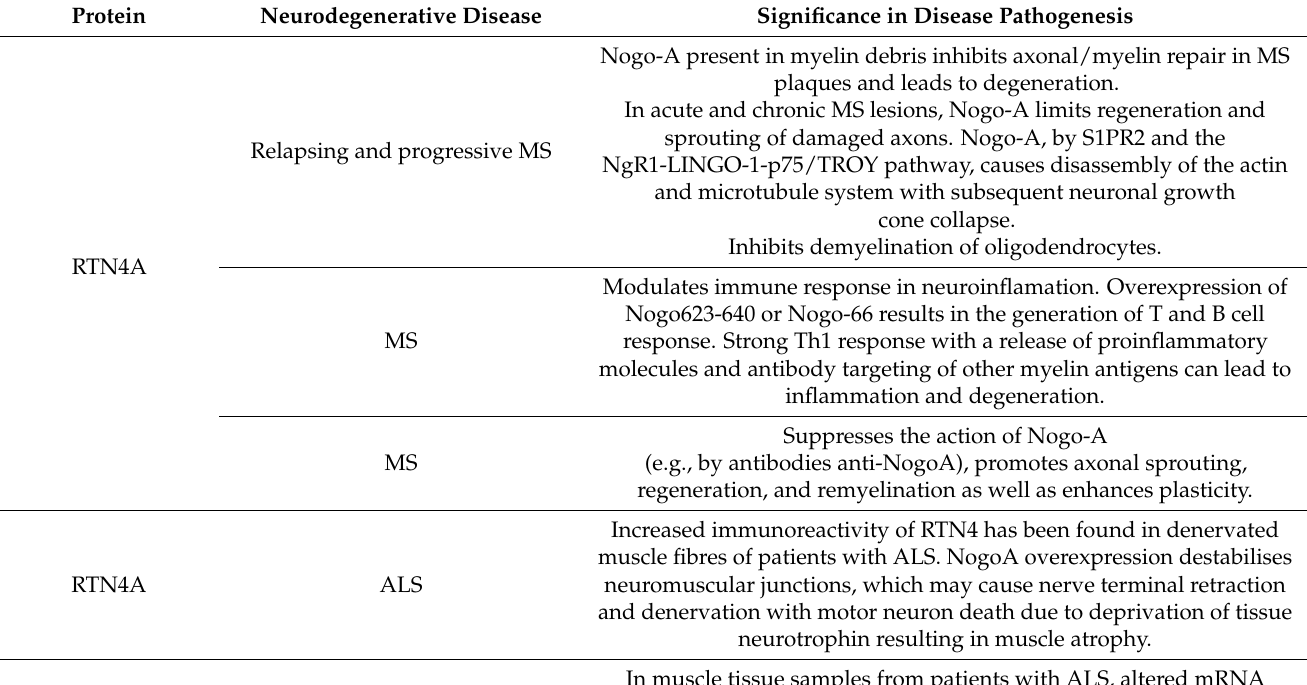
Table 4. The role of RTNs in neurodegenerative diseases.